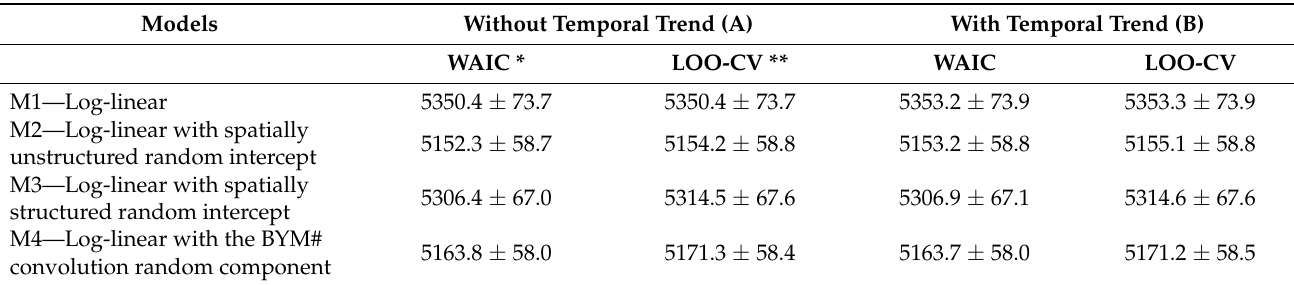
Table 3. Information criteria evaluated during the modelling phase. All information criteria are shown with their stan- dard